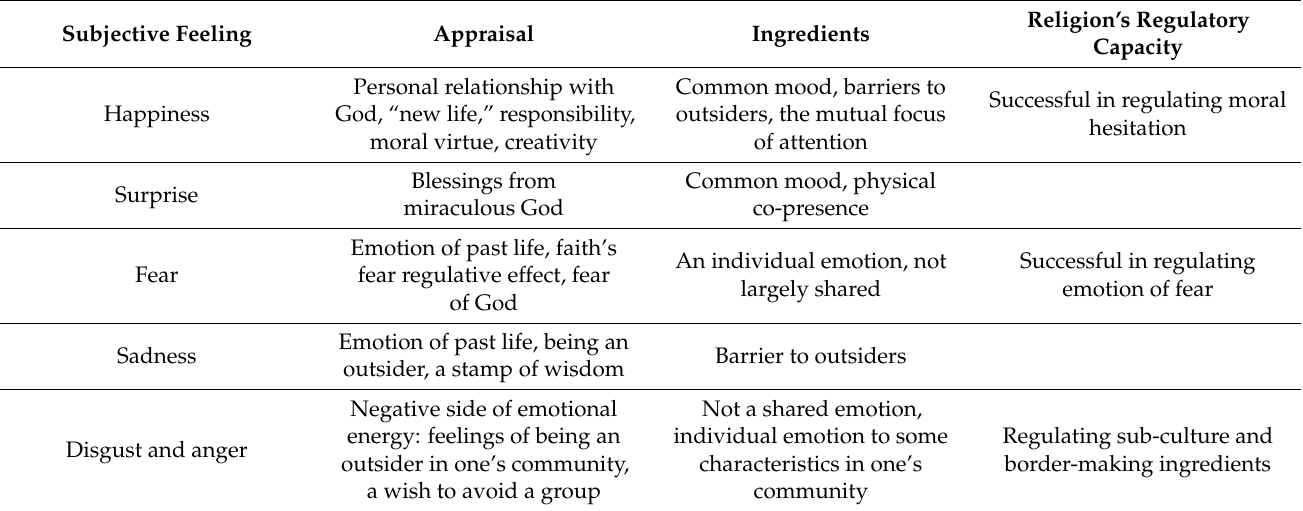
Table 1. Emotions within charismatic community building group commitment and emotion